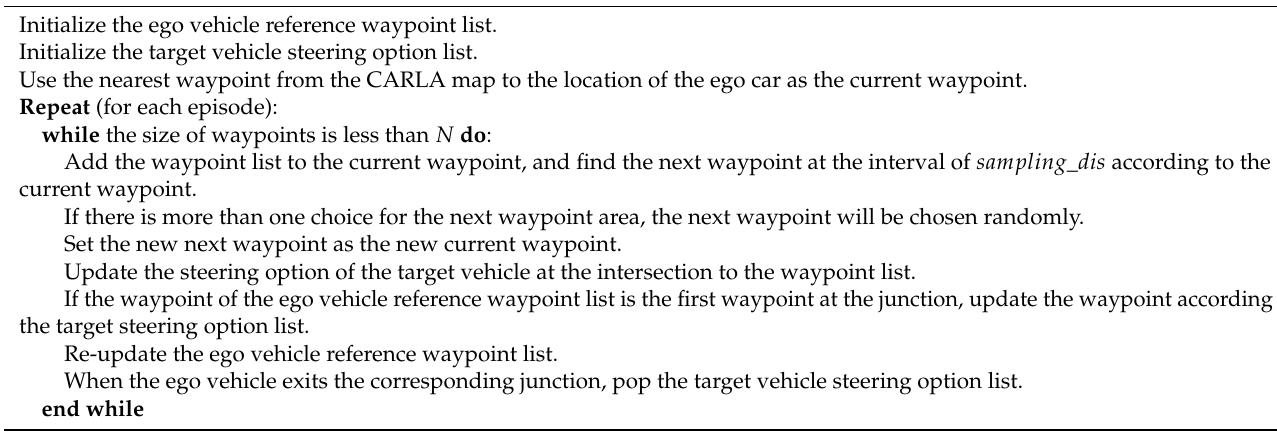
Figure 4. Waypoints at the road junction.